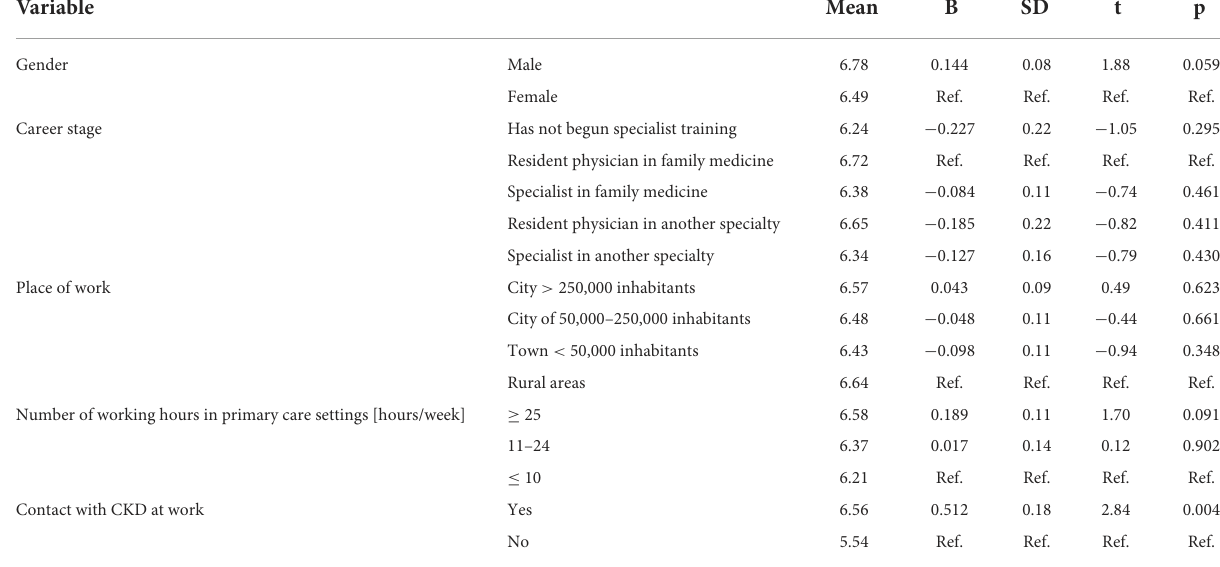
TABLE 3 The comparison of mean scores according to gender, career stage, place of work and past contact with CKD.